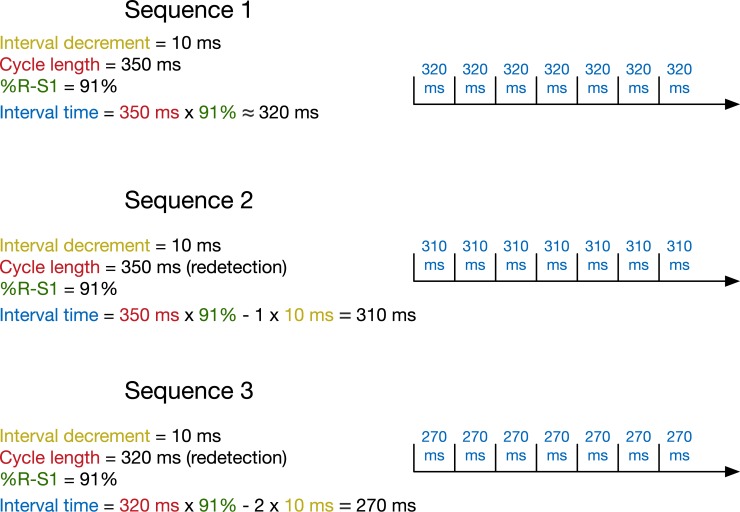
Schema of a burst ATP therapy. Shown are three sequences, with P = 7 pulses.The interval time between pulses is given by the detected cycle length times the coupling interval (%R-S1) minus an interval decrement for each repetition.